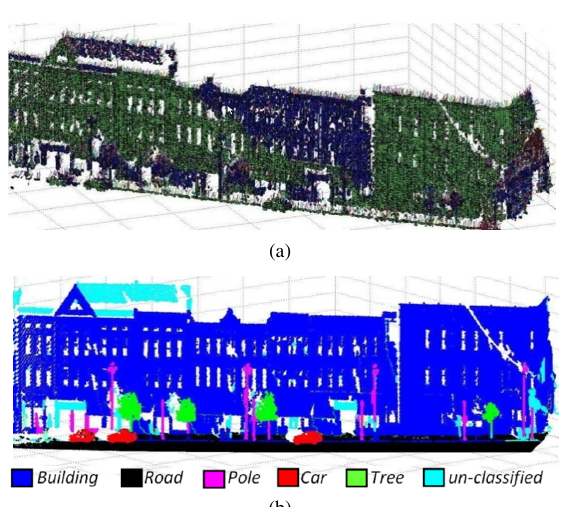
Figure 1: (a) Voxel based segmentation of a particular scene. (b) Classified 3D